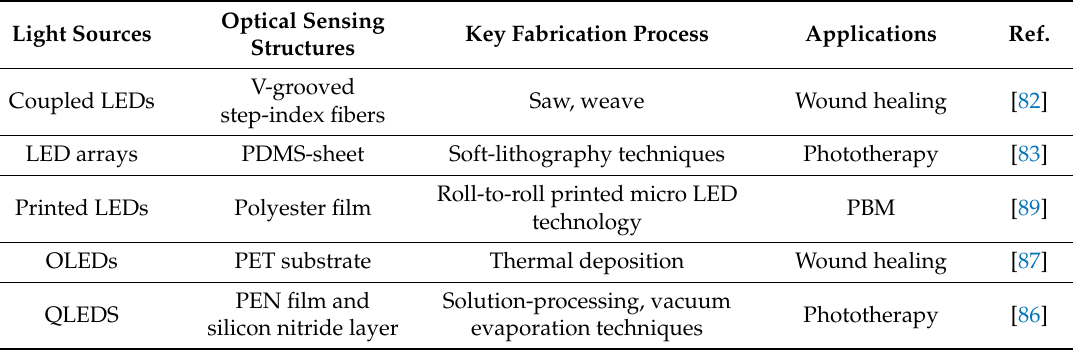
Table 5. Integrated wearable optical devices for